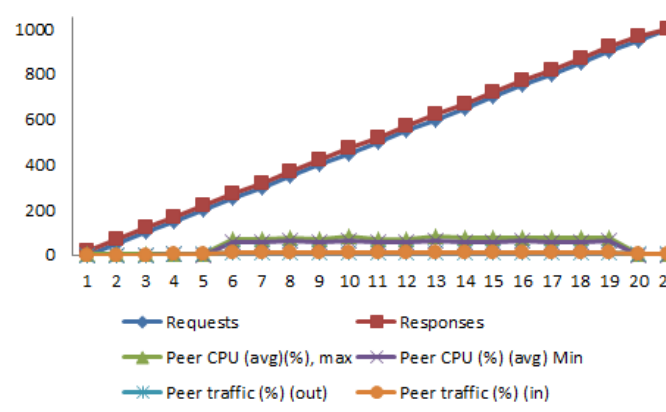
Figure 19. Single benchmarking run.